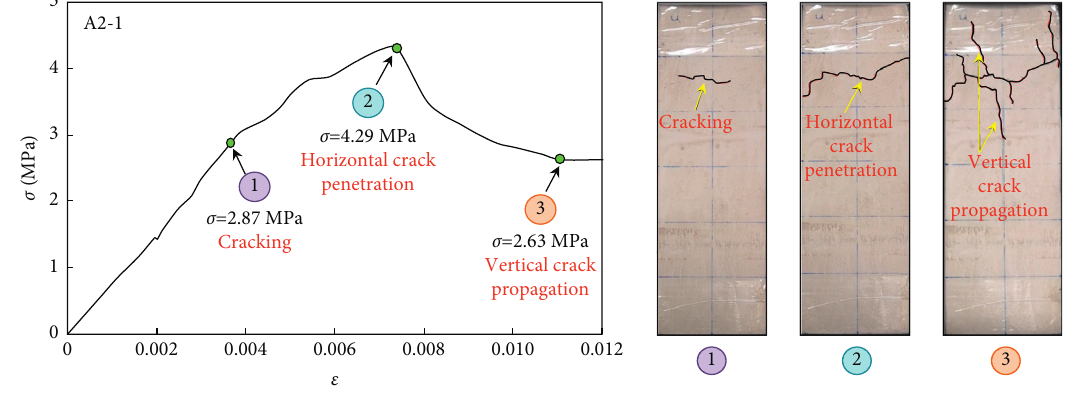
Figure 5: Failure process of specimen A2-1.